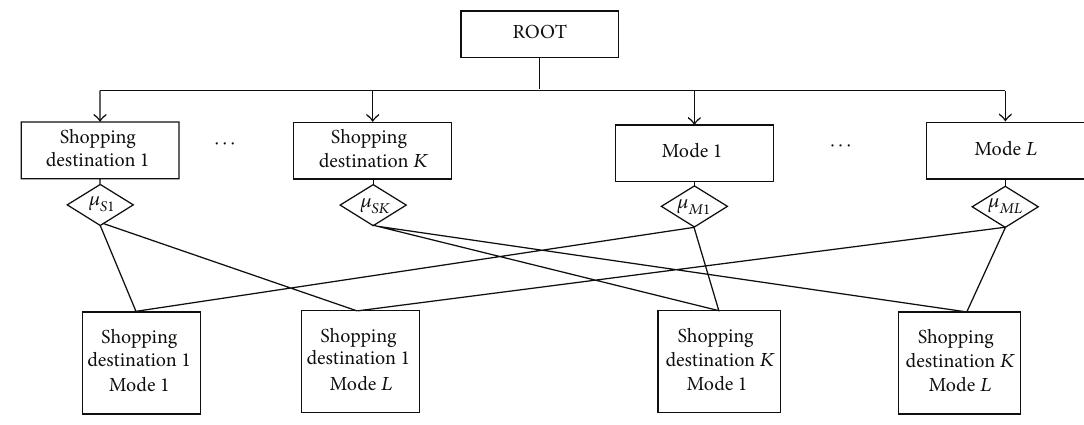
Figure 4: Structure of two-level CNL model, using nesting along the shopping destination and travel